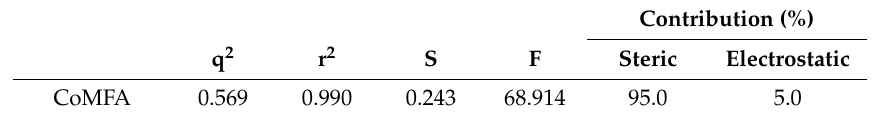
Table 3. Summary of CoMFA